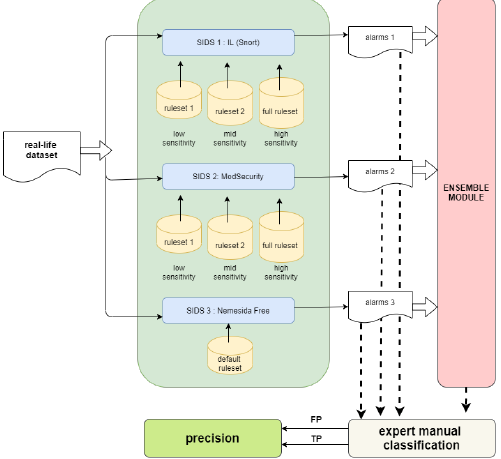
Figure 3. Experiment 2: false alarm and